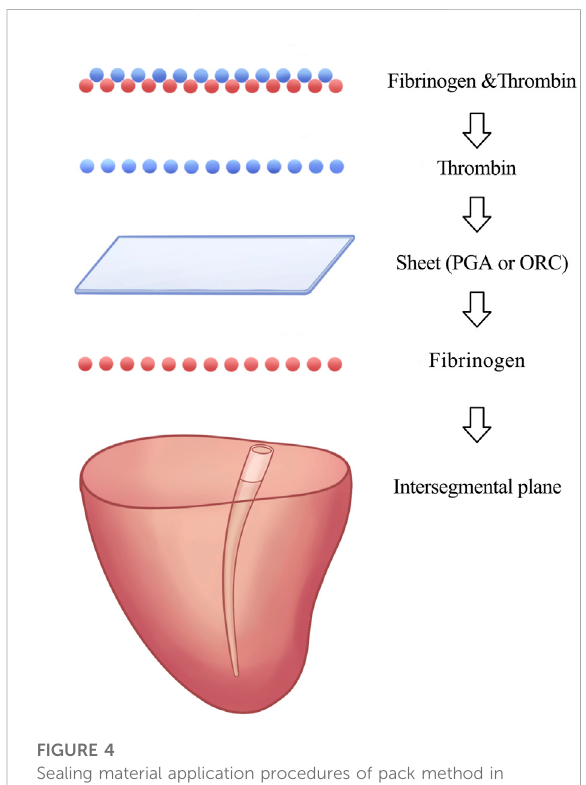
FIGURE 4 Sealing material application procedures of pack method in experimental groups (A) and (B)